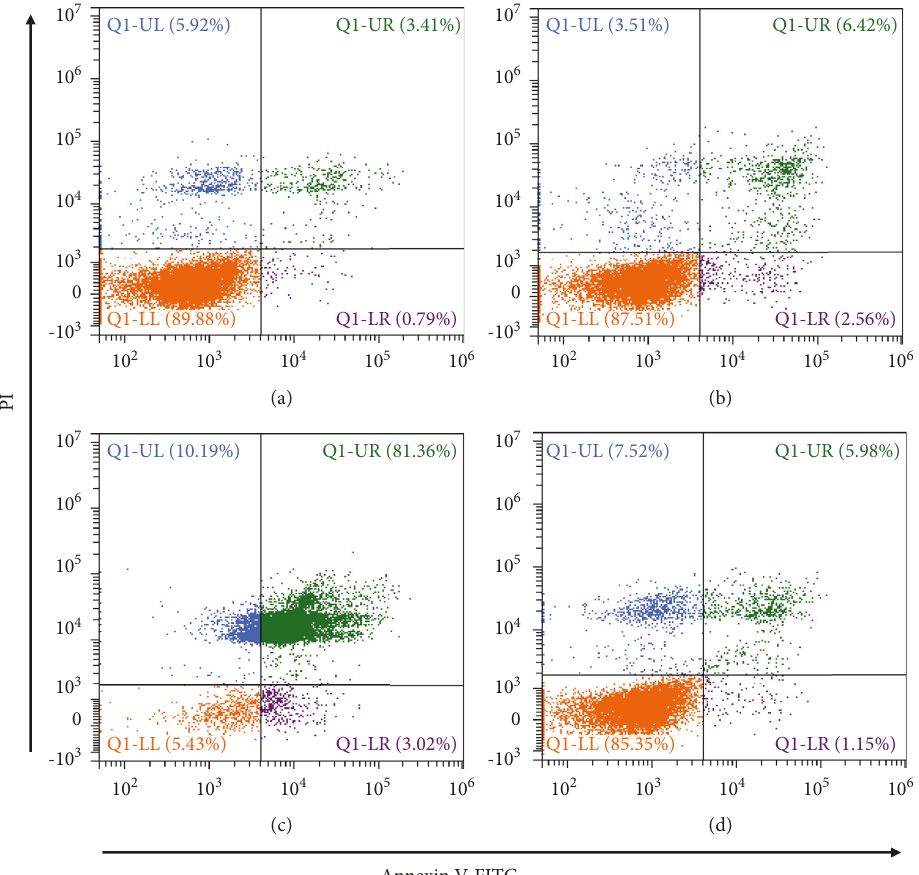
Figure 5: CAP-induced apoptosis rates of CAL-62 cells in (a) control, (b) 15s CAP-treated cells, (c) 30s CAP-treated cells, and (d) 30s CAP- and NAC-treated cells. In each small image, the lower left quadrant represents living cells, while the lower right quadrant and the upper right quadrant represent early and late apoptotic cells,